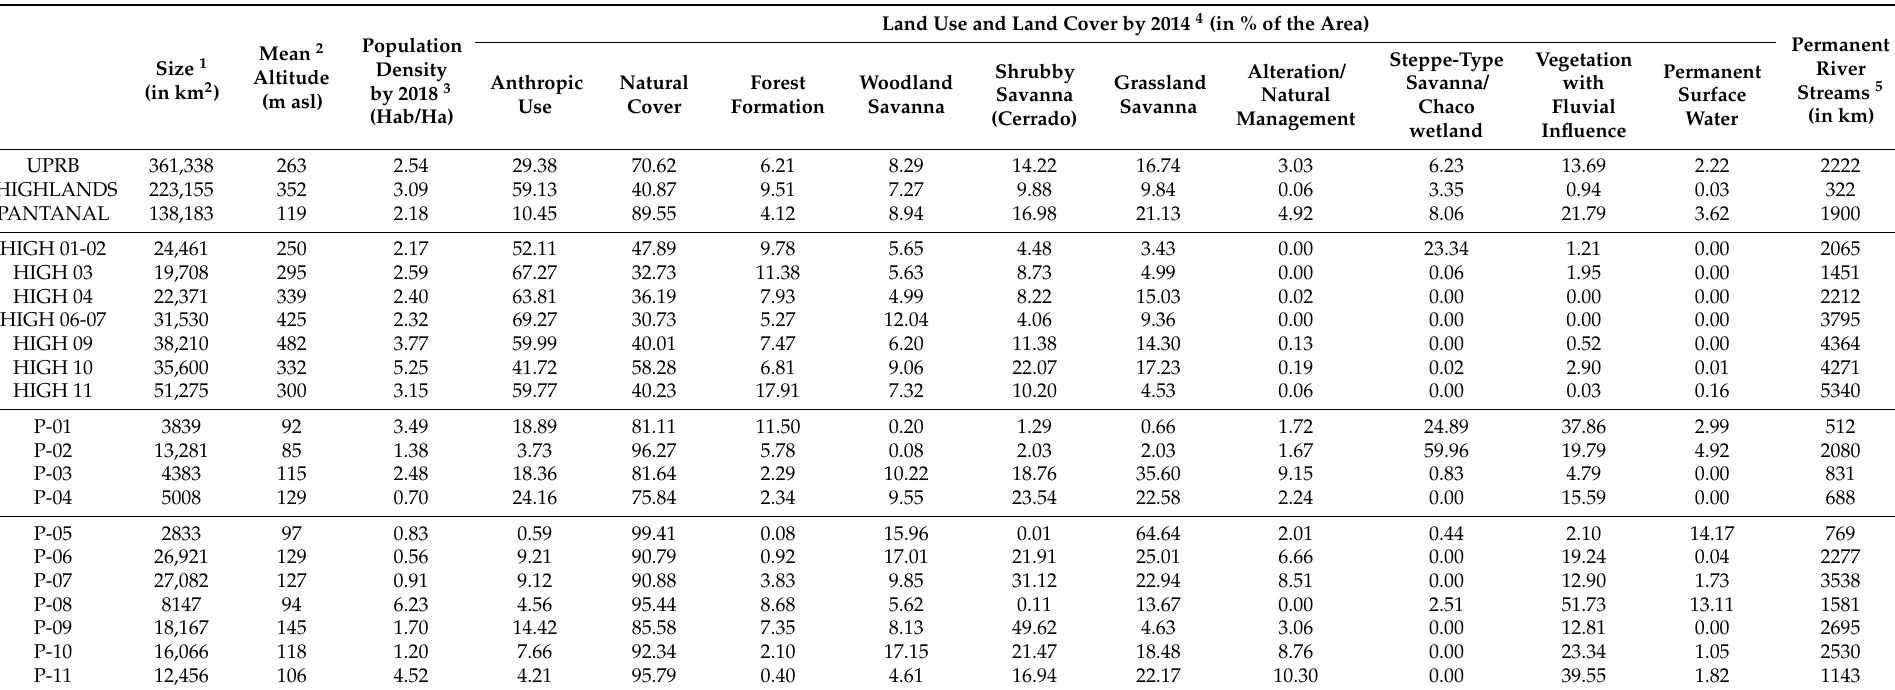
Table 1. Characteristics of the regions and subregions encompassed in the study area regarding several physical, natural and anthropic variables. In each case, the values were estimated by means of GIS tools and from freely available